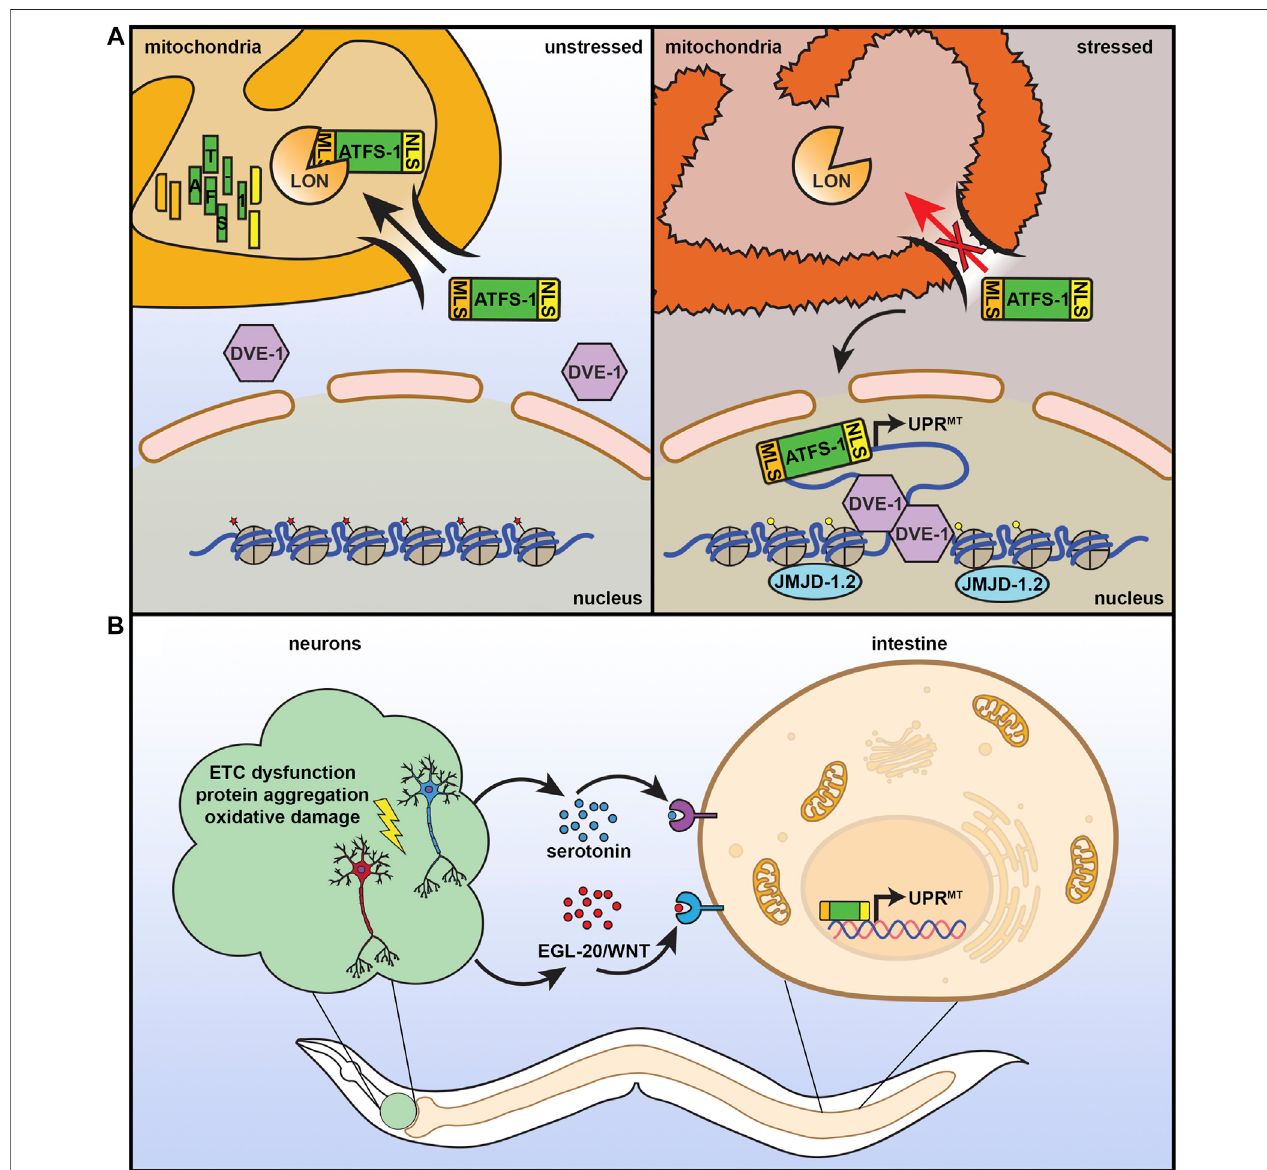
FIGURE2| Themitochondrialunfoldedproteinresponse. (A) ATFS-1isauniqueproteinthatcanserveasasensorformitochondrialhealthand fi tness.Itcontains both a nuclear localization signal (NLS) and a mitochondrial localization signal (MLS). Under basal, unstressed conditions, ATFS-1 is imported into the mitochondria where it is degraded by LON protease. Under conditions of mitochondrial stress or damage, mitochondrial import decreases, allowing ATFS-1 to instead accumulate in the mitochondria where it canactivate UPR MT with additional transcriptional regulators including DVE-1 and chromatin regulator JMJD-1.2. (B) Similar totheHSR, UPR MT canalsobecommunicatedinanonautonomousmanner.Neuronsthatexperiencemitochondrialstresscansignaltotheperipheraltissue,includingtheintestine, through serotonin and WNT signaling to result in systemic activation of UPR MT , increased stress resilience, and increased lifespan.